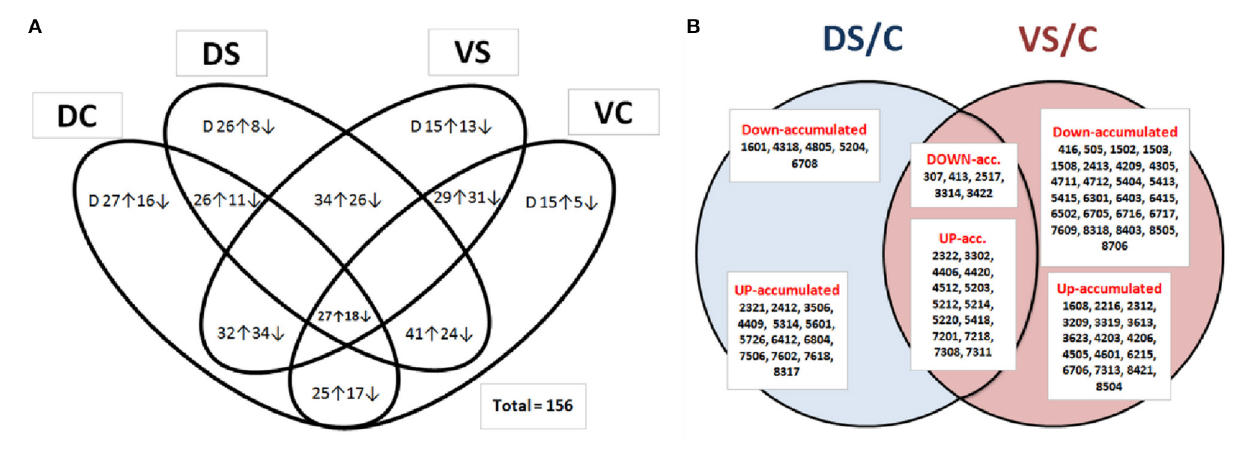
FIGURE 3 | Venn diagram of protein abundances. Venn diagram of identified and non-identified spots (A) , showing all differentially abundant protein spots (at least 2-fold change at p < 0.05 and SD ≤ 0.5; n = 156), revealing differential abundance between PEG-treated and control samples (DC, Cadeli control; DS, Cadeli stress; VC, Viking control; VS, Viking stress). Venn diagram (B) showing SSPs of unique identified protein spots (at least ± 2-fold change at p < 0.05 and SD ≤ 0.5; n = 63), revealing differential abundances between PEG-treated and control samples among genotypes. DS/C, Cadeli-treated/control, 18 SSPs; VS/C, Viking-treated/control, 41 SSPs and its union (19 SSPs). ↑ The arrow means increased abundance with respect to a ratio, while ↓ means decreased abundance with respect to a ratio. Letter “D” in Figure 3A inside ovals means a change of protein spot density just over the background of DIGE gels (at least 2-fold change; p < 0.05 and SD ≤ 0.5) because they do not have a comparison to other